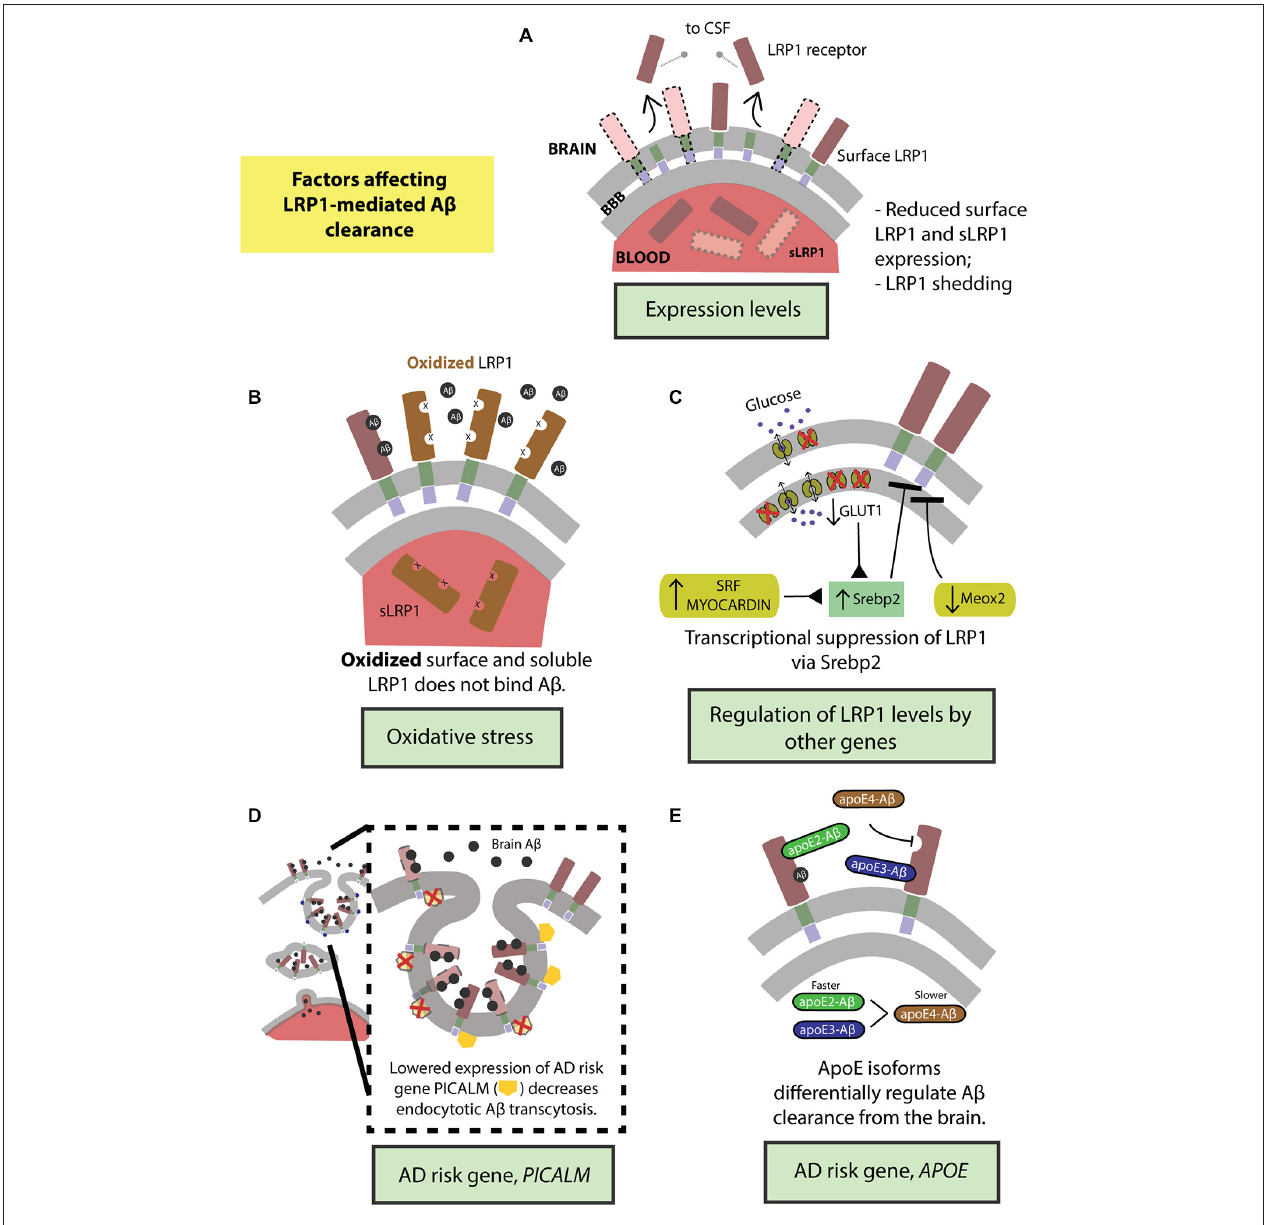
MEOX2 in brain endothelial cells. Moreover, well-known highly replicated Alzheimer’s disease (AD) genetic risk factors including PICALM (D) and APOE4 gene (E) influence endocytosis and transcytosis of A β -LRP1 complexes across brain endothelium of the blood-brain barrier. See “Factors Regulating LRP1-Mediated A β Clearance” Section for a more detailed